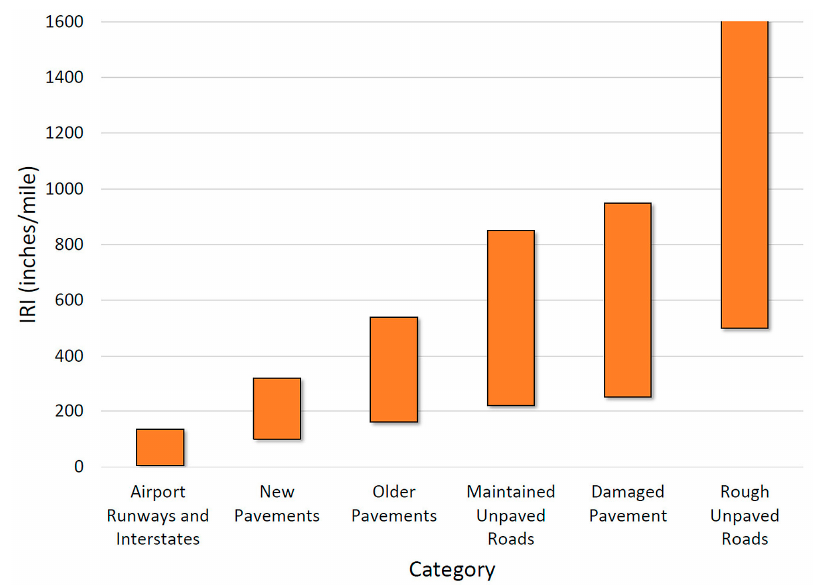
Figure 2. Figure 2. International Roughness Index (IRI) roughness scale and its relationship to road surface conditions.